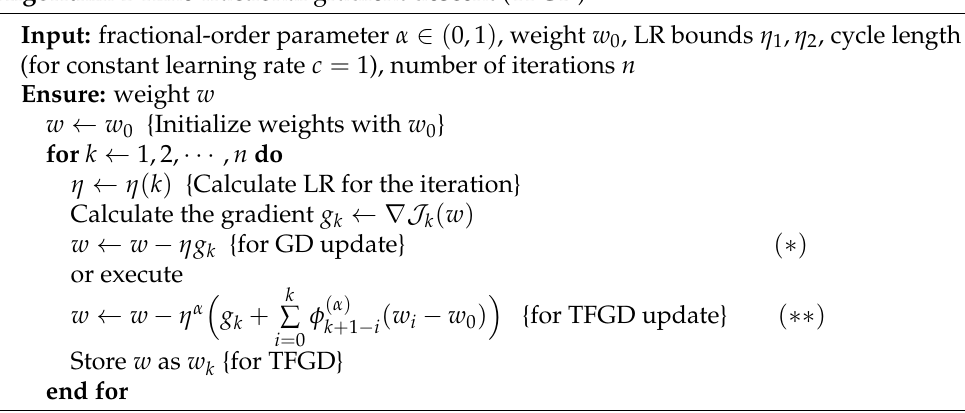
Algorithm 1 Time-fractional gradient descent